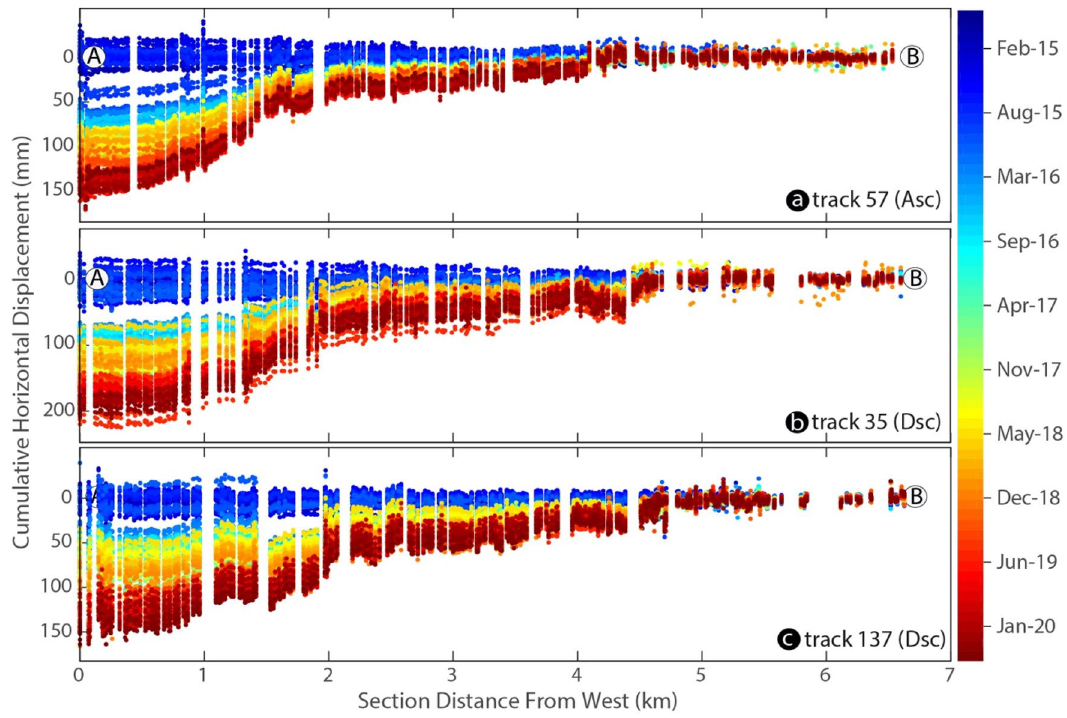
Figure 3. Profiles of InSAR LOS displacement time series (2014–2020) obtained from each track used in this study over the assumed stable area. The profile is marked by the swath profile A–B presented in Fig. 2d. This figure was created with MATLAB (R2011a). (https:// www. mathw orks. com/ produ cts/ matlab.